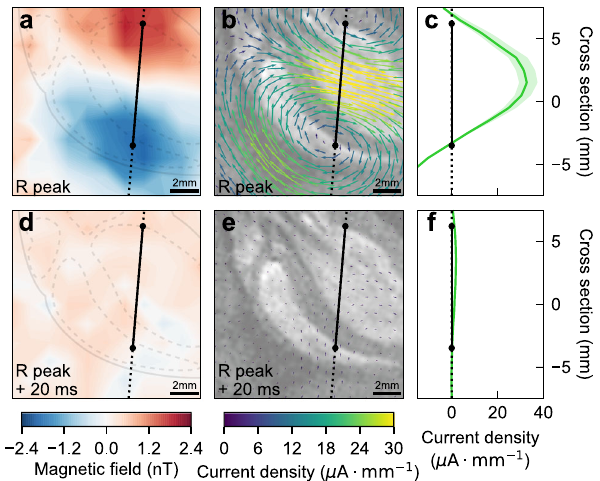
Fig. 3 Millimetre-scale cardiac magnetic fi eld mapping. a Optical image of the rat ’ s heart. b , c Measured magnetic fi eld map at the timing of the R-wave peak obtained with the nitrogen-vacancy (NV) centres for d NV ¼ 7 : 5 ± 0 : 5 mm and with the optically pumped magnetometer (OPM) for d OPM ¼ 14 ± 2 mm, respectively. The fi eld of view is the same as that of the optical image, with an accuracy of better than 2 mm. The superimposed grey solid line shows the contour of the rat ’ s heart traced from the magnetic resonance imaging (MRI) ( d ). d Magnetic resonance image of the rat ’ s heart, the orientation of which is adjusted to the optical image. The Purkinje fi bre bundle is located in the inner ventricular walls between the left and right ventricular. e , f Fitted magnetic fi eld map using the multiple- current-dipole model, superimposed on the contour of the internal structure of the rat ’ s heart (grey dashed line) revealed by MRI ( d ). The black arrows represent the location, direction, and relative magnitude of the central dipole. The black dash-dotted circle depicts the localisation precision of the central dipole. The current dipoles are estimated such that the mean squared error between the measured and simulated magnetic fi elds is minimal. presented a dipolar pattern with a pole-to-pole spacing of Δ NV = 9.7 ± 0.6 mm (Fig. 3b). This spreading was smaller than that obtained from rat D with an OPM at a measured standoff distance of d OPM = 14 ± 2 mm (Fig. 3c).